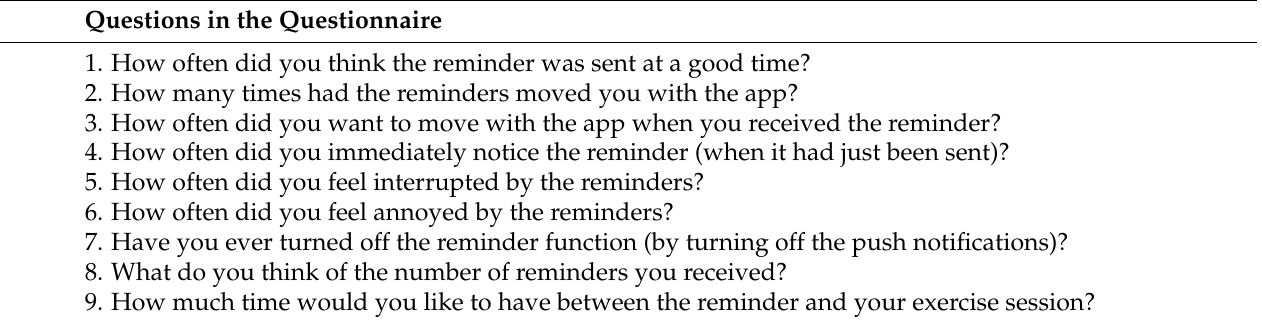
Table 2. Questions in the questionnaire and the interview about user experience on received reminders. Questions in the